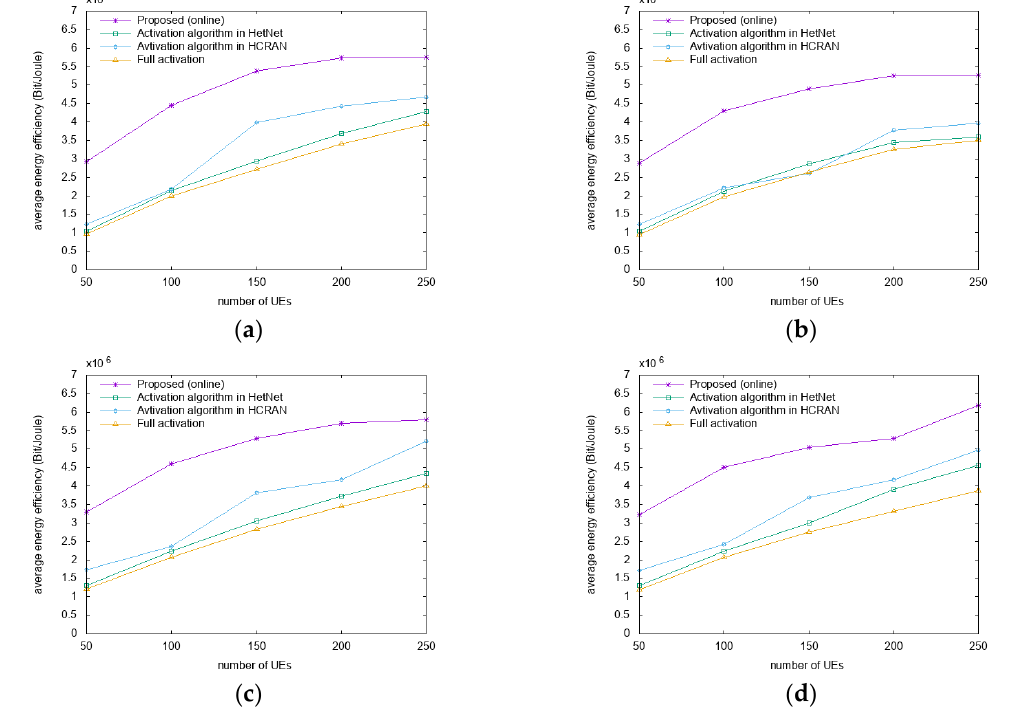
Figure 5. Comparison of the energy efficiencies. ( a ) 2x and ( c) 4x speeds with Gaussian distributions; ( b ) 2x and ( d ) 4x speeds with uniform distributions.